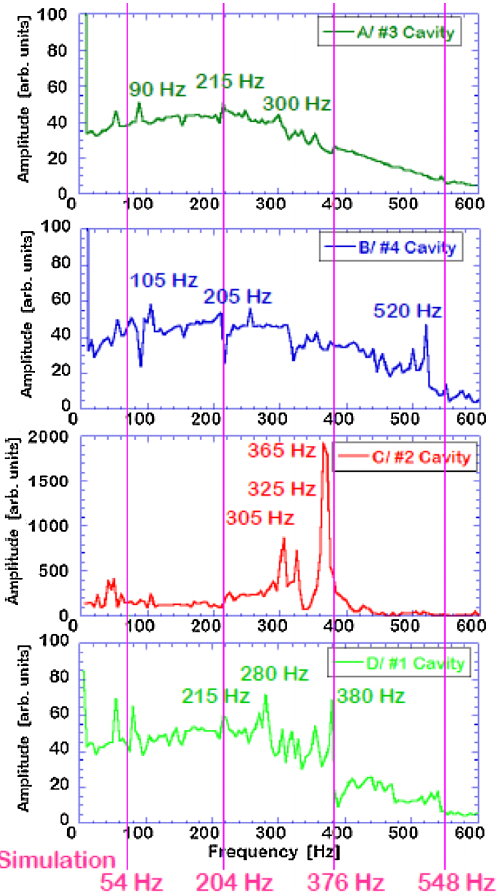
FIG. 17. (Color) FFT analysis of mechanical vibration modes in four cavities. The mechanical vibration modes between 0 and 600 Hz are shown, and no remarkable mode above 600 Hz is observed. The accelerating gradients in each cavity are 18 : 4 MV = m (#3 cavity), 18 : 6 MV = m (#4 cavity), 28 : 2 MV = m (#2 cavity), and 18 : 0 MV = m (#1 cavity). The purple lines show the mechanical vibration modes obtained by the simulation in the model calculations. The different vertical scale in the figures is due to the sensitivity of the different piezo elements used in the four cavities; low-voltage-type piezos (#3, #4, and #1 cavity) and high-voltage-type piezo (#2 cavity).